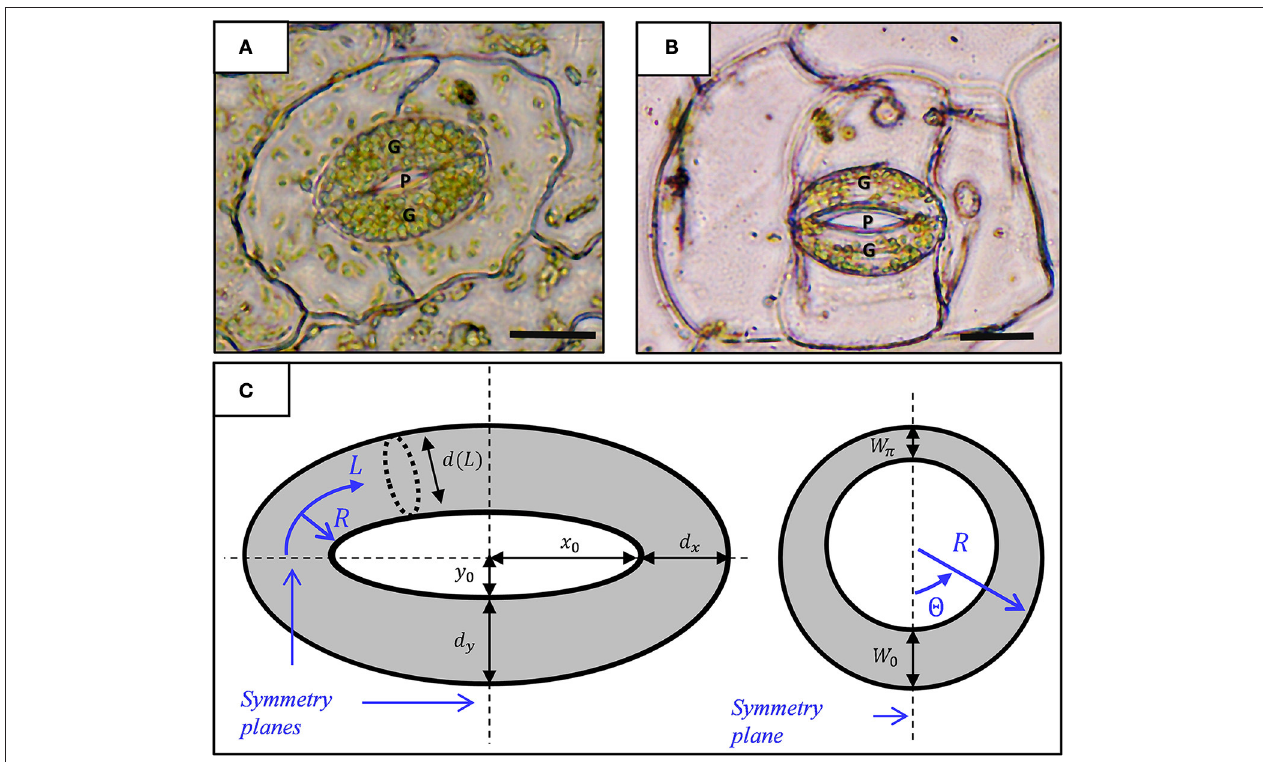
FIGURE 1 | Micrograph showing a stoma of the fern Nephrolepis exaltata (A) and the angiosperm Tradescantia pallida (B). A typical kidney-shaped stoma comprises two guard cells (G) with a pore (P) between them. Scale- guard cells are enclosed by elliptical contours of radii (curvilinear coordinates), respectively. The interior of the guard cell with inner diameter d ( L ) is enclosed by a non-uniform wall of thickness W 0 W ( 2 note that d ( L ) ≫